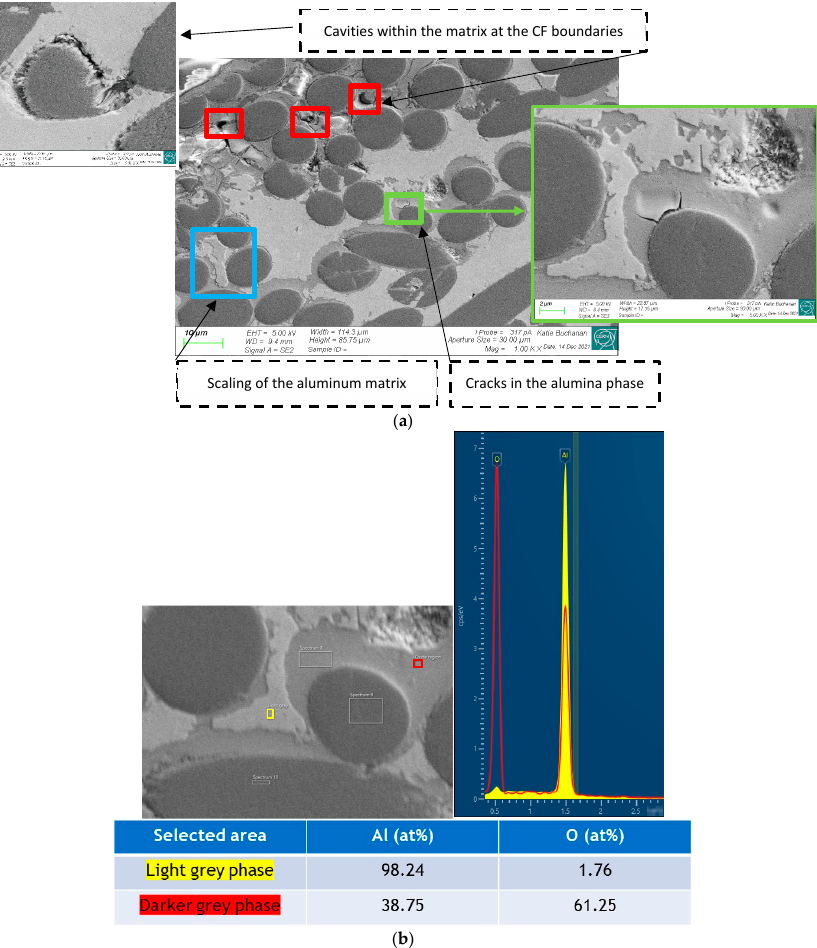
Figure 9. ( a ) Transverse cross-sectional cut of the PM sample shown in Figure 8. Cavities are present at the boundary between the Al and the C f s, locally filled with corrosion residues. The grey phase (identified by an arrow), whose stoichiometry is close to alumina, features a brittle appearance with cracks developing close to the C f s. ( b ) EDS analysis of the dark grey phase shows a composition close to Al 2 O 3 (Al 38.75 at.% and O 61.25 at.%), while the adjacent matrix is almost pure Al (98.24 at.%).